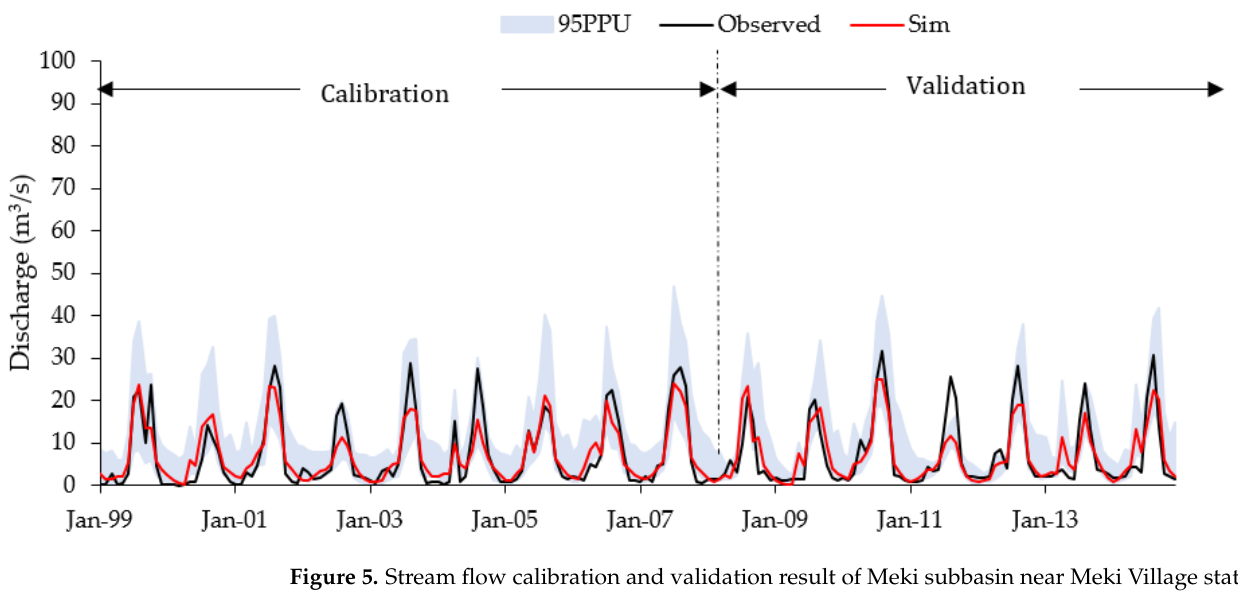
Figure 5. Stream flow calibration and validation result of Meki subbasin near Meki Village station (1999–2014). Table 5. SWAT model performance evaluation for Meki and Katar